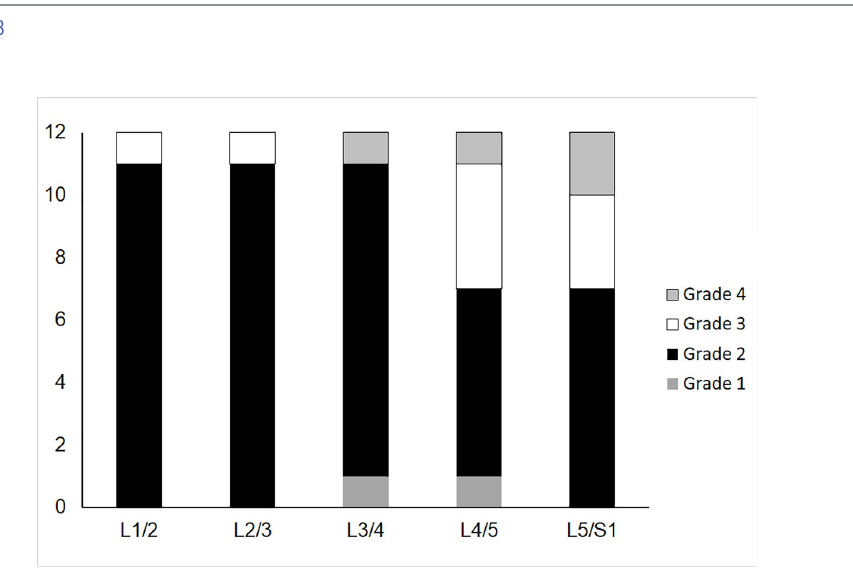
Fig 4. Number of intervertebral discs in each Pfirrmann Grade at each vertebral level. Due to the limited numbers of Grade 1 and Grade 4 intervertebral discs, analysis of reliability in different grades focuses on Grades 2 and 3 (see Results and Table 4).